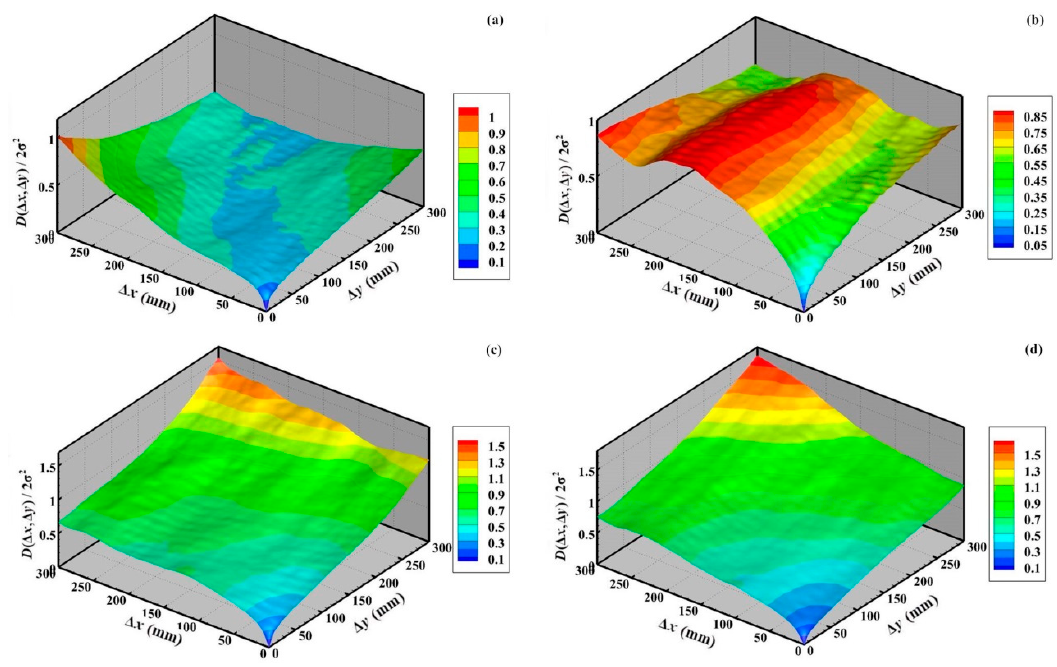
Figure 8. The second-order structure function plot of Run 3 and Run 4: ( a ) Run 3-0; ( b ) Run 3-1; ( c ) Run 4-0; and ( d ) Run 4-1.